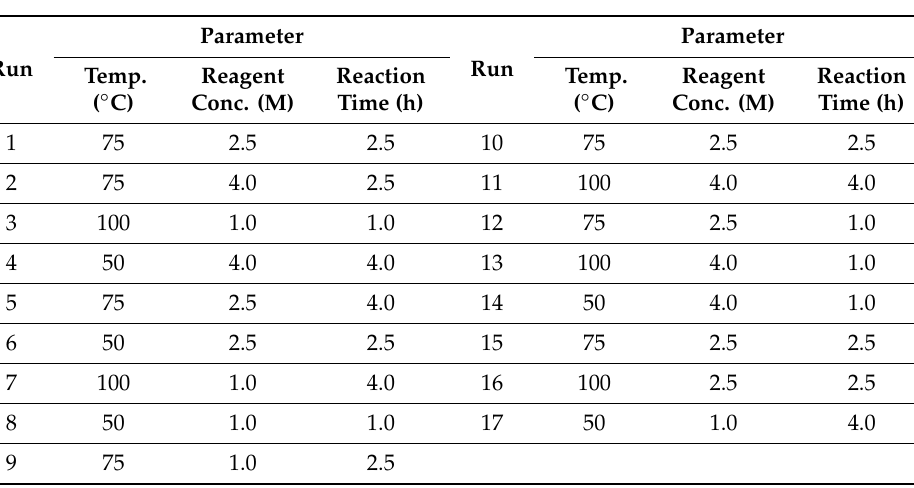
Table 2. Experimental matrix of the variables for leaching